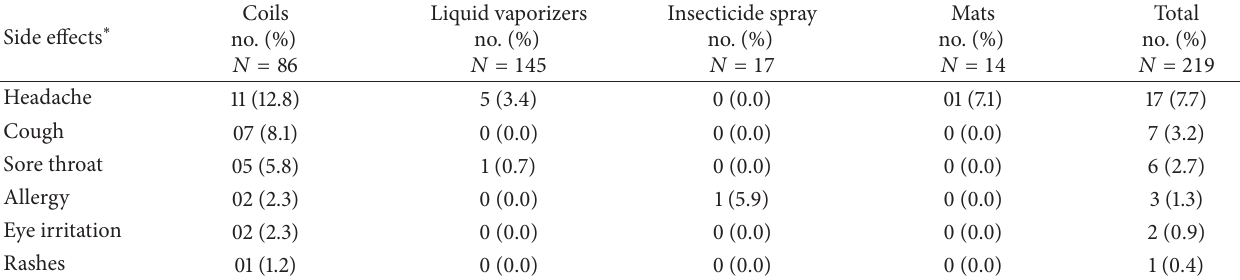
Table 3: Perceived side effects with respect to personal protective measures against mosquitoes among current